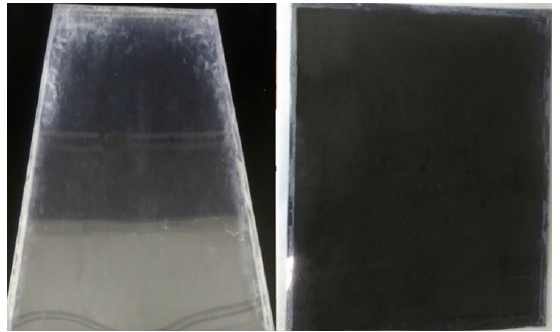
Figure 5. Photographs of the panels without ( left ) and with the CaCl 2 ·6H 2 O /EG composite PCM ( right ). Reproduced with permission from [82]. Elsevier, Applied Energy, copyright 2017.